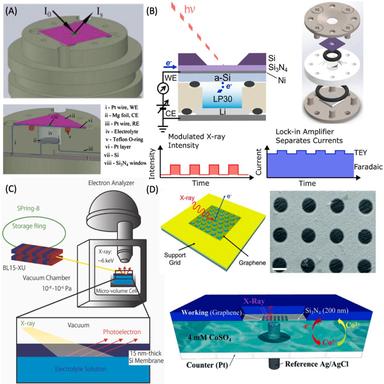
.2. Enclosed electrochemical cells for XPS and XAS of battery interfaces. (a) XAS cell sealed with ~100 nm SiNx membrane, used primarily for FY measurements; (b) TEY-XAS cell and lock-in approach for separating faradaic and TEY currents, used to study SEI formation on a-Si; (c) Silicon membrane approach for studying solid-liquid interfaces with XPS using ~6 kV X-ray excitation; (d) Graphene Membrane approach for studying the solid-liquid interfaces with XPS, so far